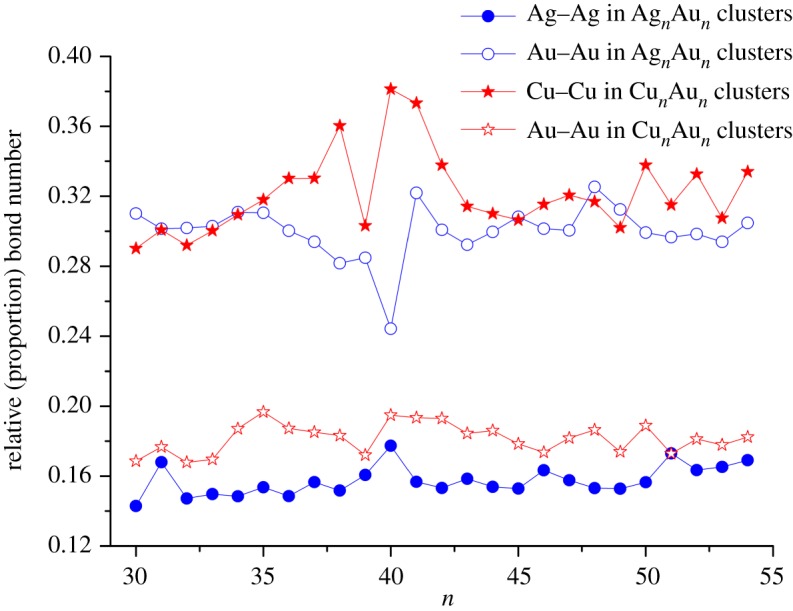
The proportion of bond number of Ag–Ag and Au–Au bonds to the total number of bonds in AgnAun (n = 30–54) clusters and the corresponding ones of Cu–Cu and Au–Au in CunAun clusters.